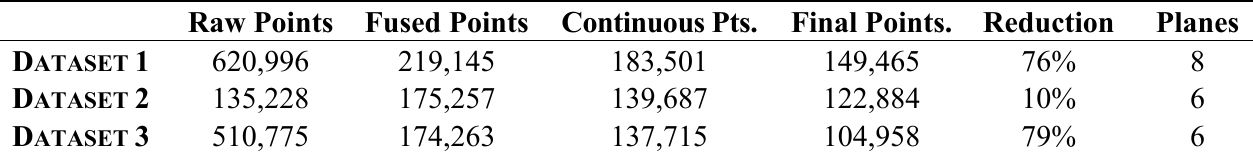
Table 1. Established calibration datasets.